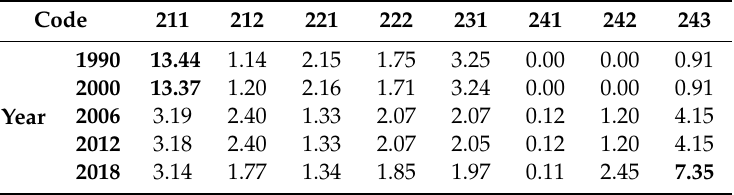
Table 4. Percentage of agricultural areas according to CORINE land cover nomenclature for level 3 in Canary Island in 1990, 2000, 2006, 2012 and 2018 (Source: authors). Table 3. Percentage of artificial surfaces according to CORINE land cover nomenclature for level 3 in Code 211 Canary Island in 1990, 2000, 2006, 2012 and 2018 (Source: authors). Code 111